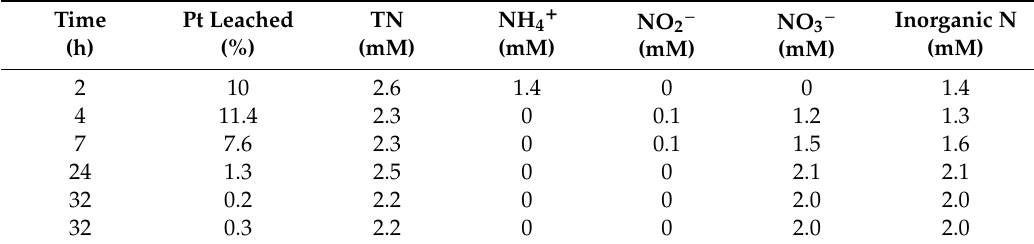
Table 3. Pt loss from the catalyst; concentrations of N-species during the reaction over 2.36% Pt / ZrO 2